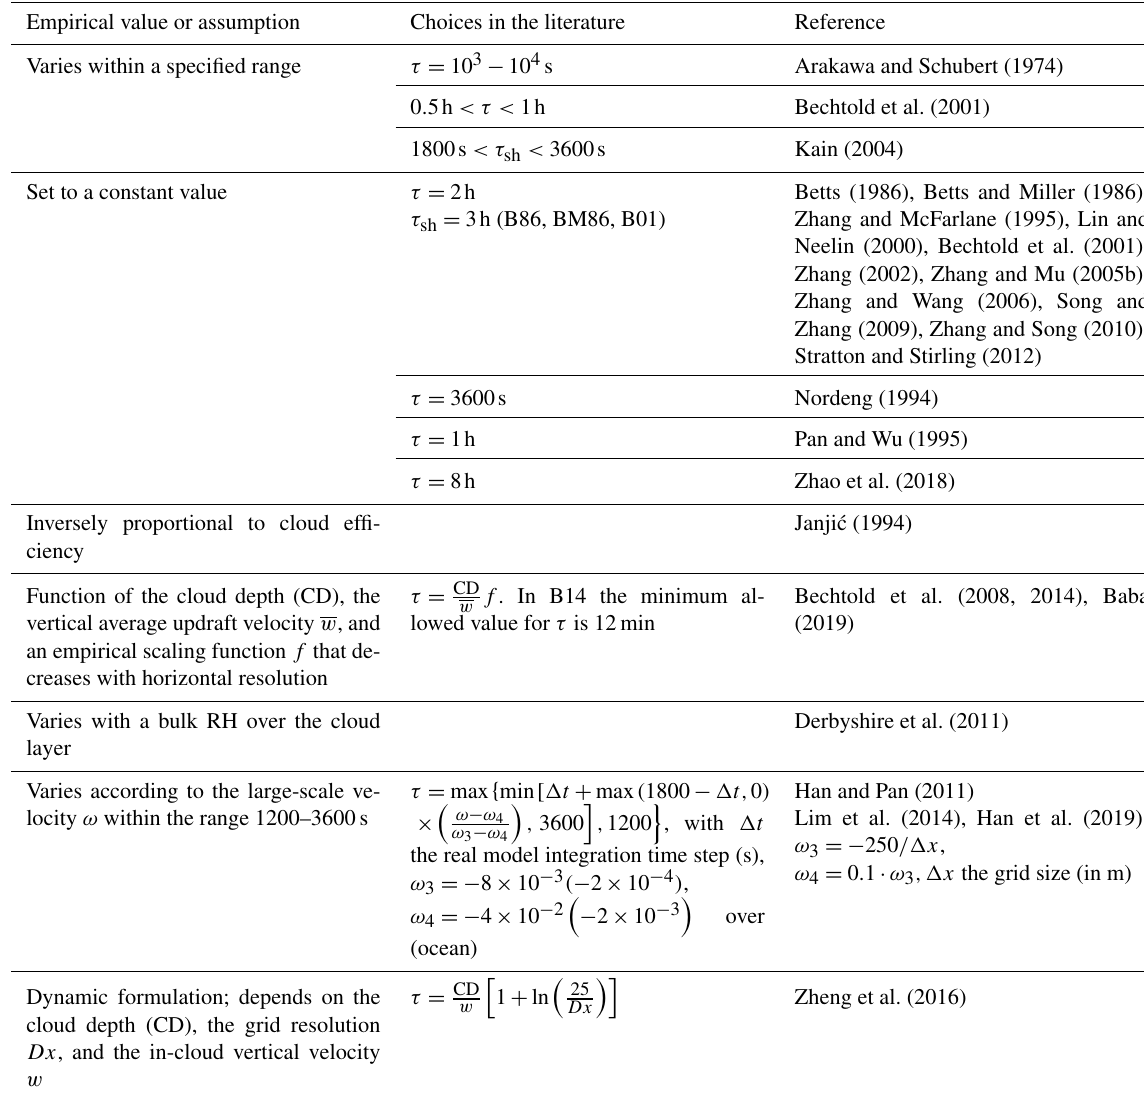
Table 13. A sample of the empirical values and assumptions in the relaxation timescale (note: subscript “sh” refers to shallow convection). Empirical value or assumption Choices in the